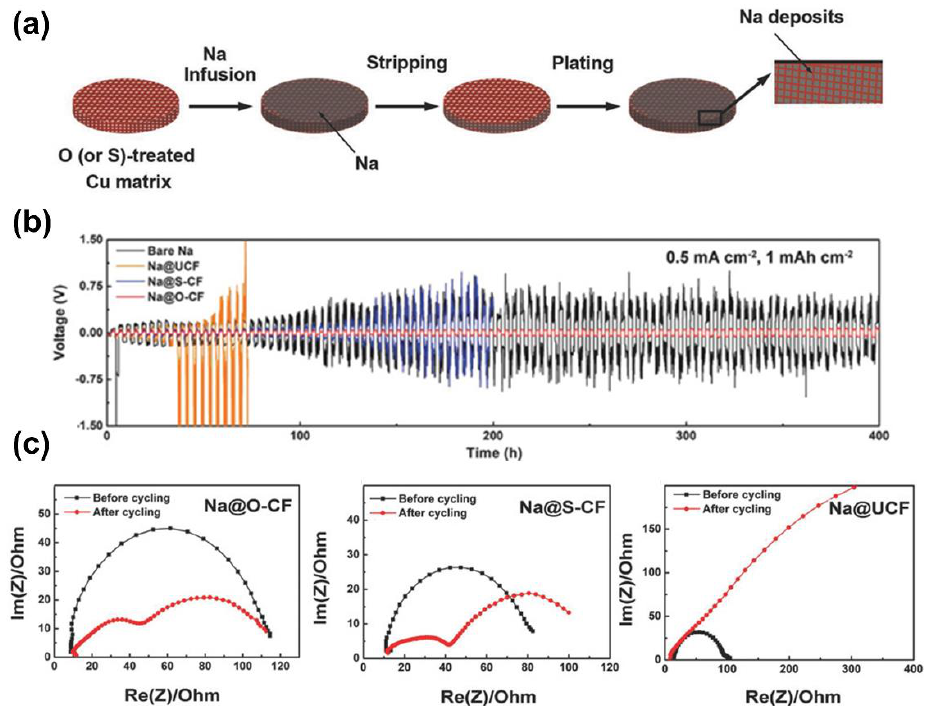
Figure 9. ( a ) Schematic illustration of molten sodium infusion into treated Cu matrix. ( b ) Comparison of the cycling stabilities of bare Na, Na@UCF, Na@S-CF, and Na@O-CF electrodes in symmetrical cells at a current density of 0.5 mA cm −2 with a capacity limitation of 1 mAh cm −2 . ( c ) The Nyquist plots of Na@O-CF, Na@S-CF, and Na@UCF before and after 30 cycles (adapted with permission from Wiley).